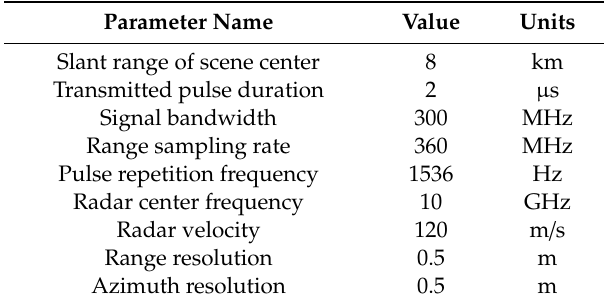
Table 2. System parameters for point target